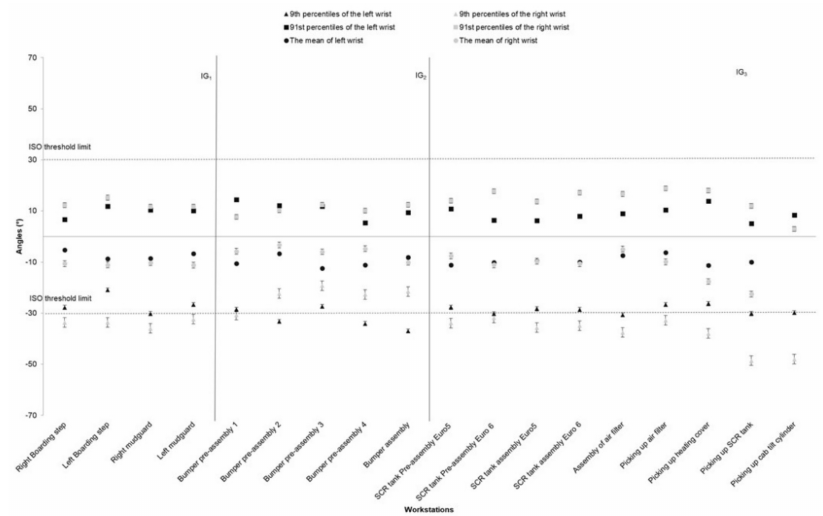
Figure 5. The right / left wrist angles (the mean, 91st, and 9th percentiles) for di ff erent workstations in the truck assembly plant, (the bars represent standard deviations). The high-risk ISO threshold limit is ± 30 ◦ for wrists flexion and extension. Note: IG = Improvement Group; error bars represent standard